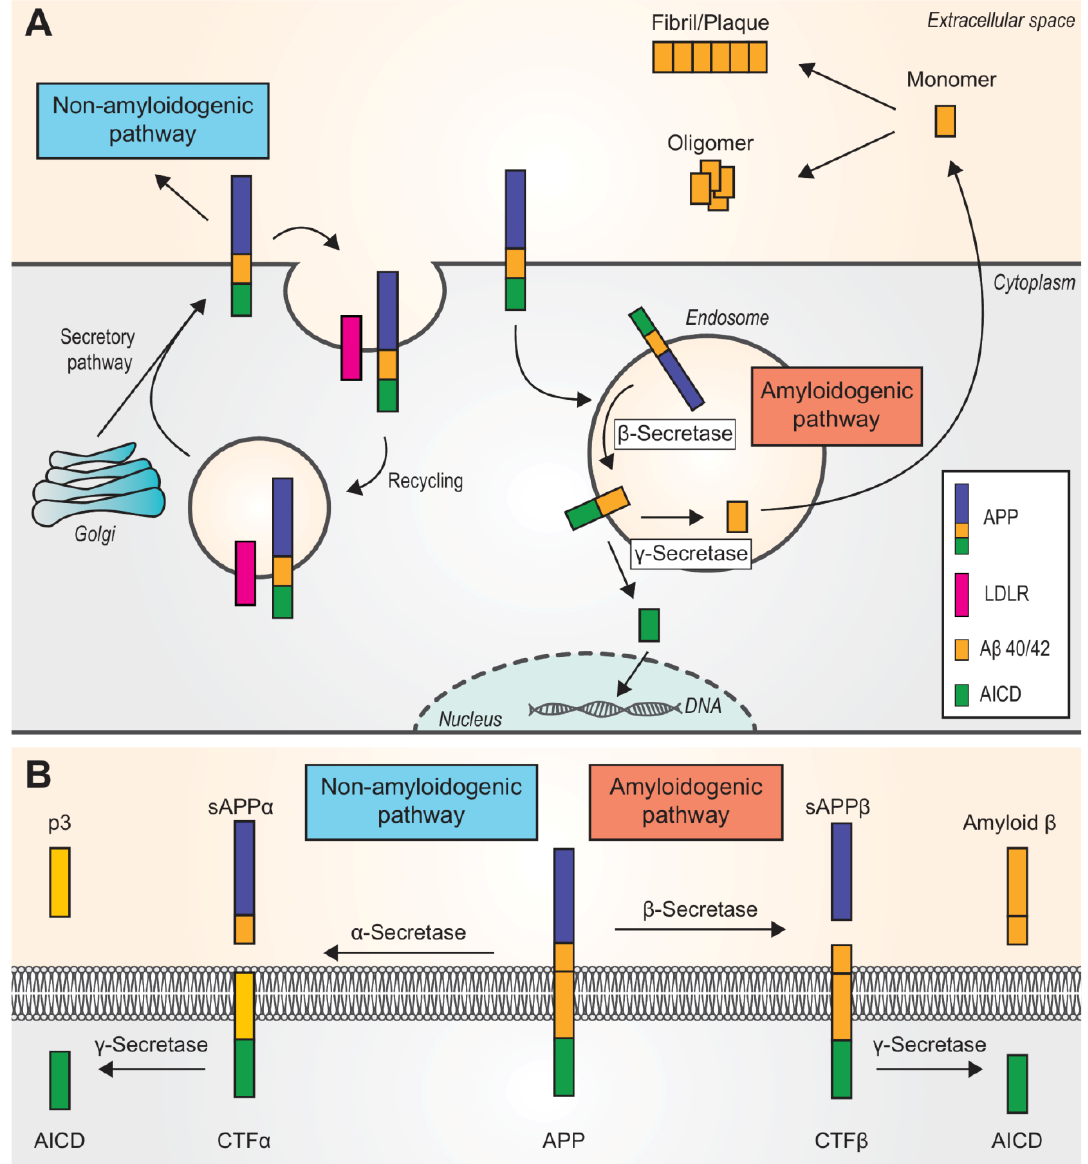
FIGURE 1: Two pathways of amyloid β (Aβ) peptides generation . Amyloid precursor protein (APP) is a type I integral membrane protein that is cleaved at different sites to yield various products. (A) An overview of the two pathways. APP is translocated from the cytoplasm into the endoplasmic reticulum where it enters the secretory pathway and then is transported to the neuronal plasma membrane. The majority of APP is processed via the non-amyloidogenic pathway (see panel B). APP can be recycled in endosomes by binding to LDLRs (low-density lipoprotein receptors). The right side of the figure shows the amyloidogenic pathway. Unlike the non-amyloidogenic pathway, which is car- ried out at the plasma membrane, the amyloidogenic pathway mainly occurs in endosomes. Ultimately, AICD is transferred to the nucleus, where it functions as a transcriptional factor, whereas the A  40/42 monomer is removed to the extracellular space. Monomers aggregate either into oligomers or fibrils/plaques. (B) Non-amyloidogenic (left) or amyloidogenic (right) pathway of APP processing. In the non- amyloidogenic pathway, APP is first cleaved by  -secretase, releasing a soluble ectodomain of APP called sAPP  and a membrane-tethered intracellular C-terminal fragment (CTF  ). Then, the C-terminal fragment is further cleaved by  -secretase to produce a 3-kDa peptide (p3) and an APP intracellular domain (AICD). In the amyloidogenic pathway, the products of  -secretase are a soluble ectodomain of APP (sAPP  ) and a C-terminal fragment β (CTFβ). The second step releases Amyloid  and AICD. APP, amyloid precursor protein. CTF alpha/beta, C- terminal fragment alpha/beta. sAPP alpha/beta, soluble ectodomain of APP. p3, 3-kD peptide. AICD, APP intracellular